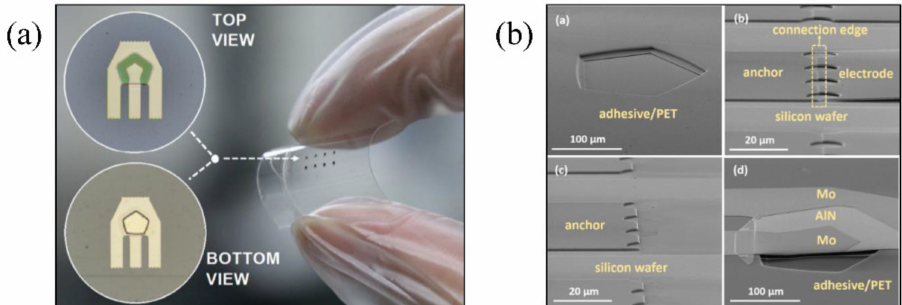
Figure 7. ( a ) Image of a flexible substrate carrying thin film resonators and local microscopy images of the resonator cavity [94] Reprinted/adapted with permission from Ref. [94]. 2017, AIP Publishing. ( b ) SEM image of the details of the flexible resonator [94] Reprinted/adapted with permission from Ref. [94]. 2017, AIP Publishing.